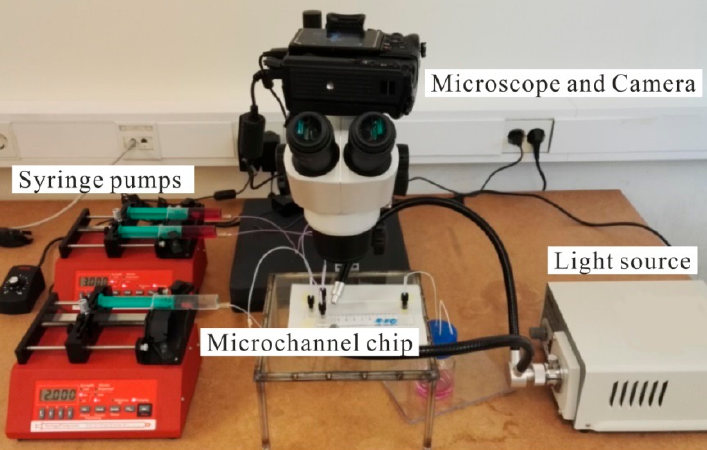
Figure 1. Experimental setup.